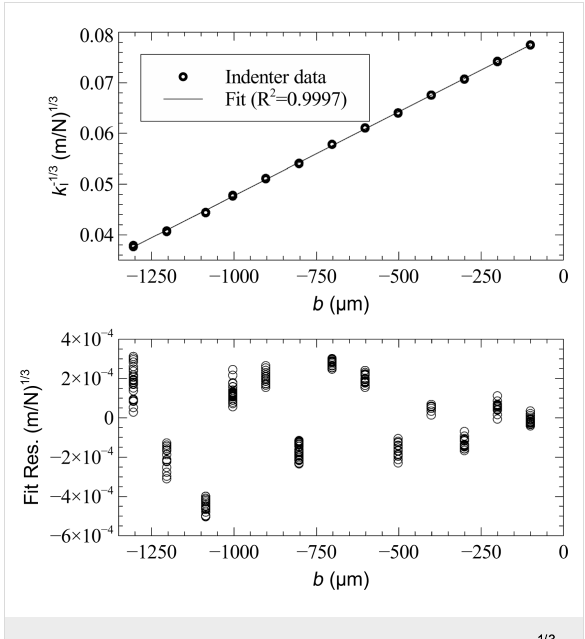
Figure 7: Nanoindenter measurements from a tunning fork tine. vs b is plotted where k I is the spring constant measured at an offset b from the distal edge of the tine. A linear least-squares regression determines EI and L of the